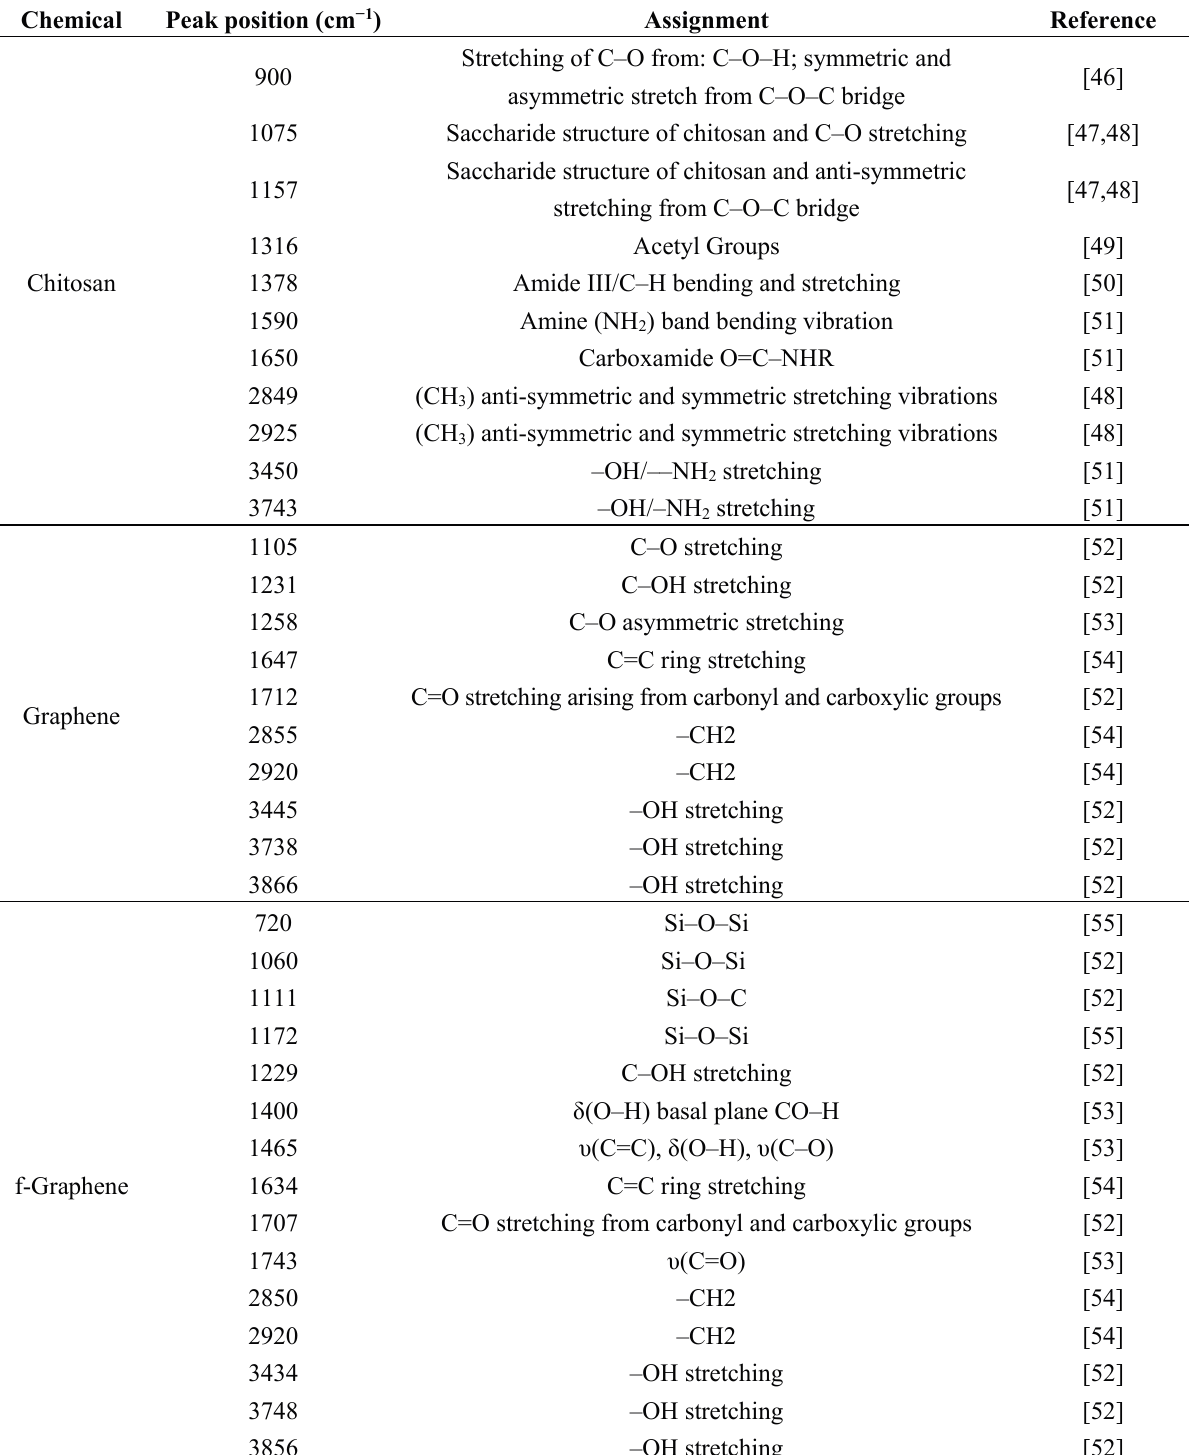
Table 4. FTIR assignments of chitosan, graphene and functionalized graphene.